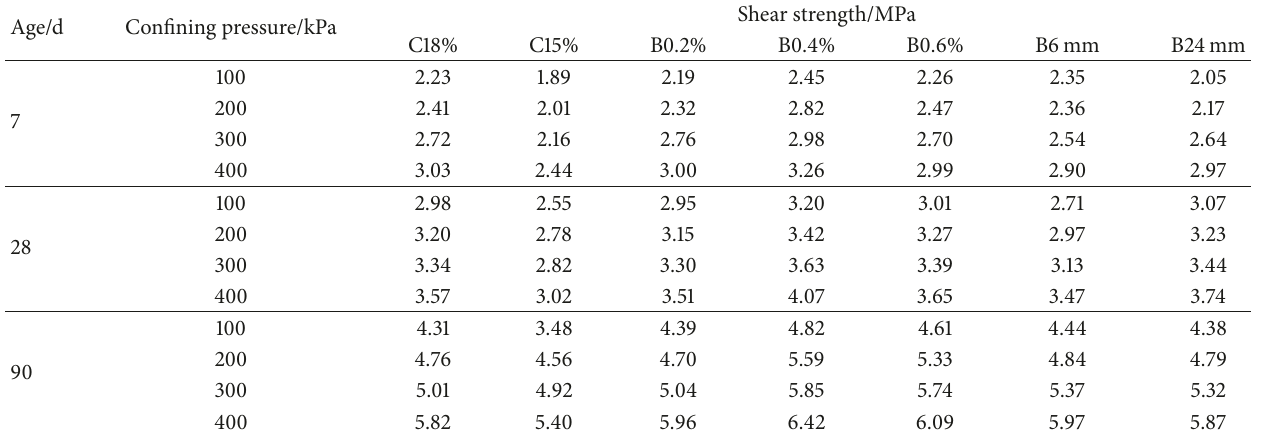
Table 8: The data of the shear strength test.